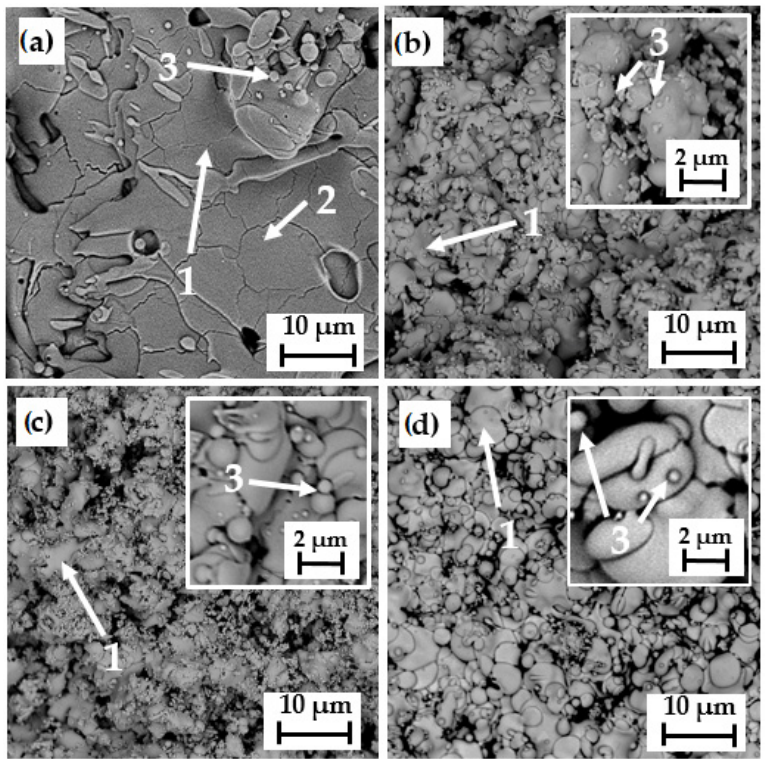
Figure 2. SEM top-surface morphologies of Al 2 O 3 coatings sprayed by: ( a ) APS, ( b ) SPS, ( c ) A-SPS, and ( d ) S-HVOF. 1—splat; 2—cracks; 3—not fully melted or re-solidified particles.